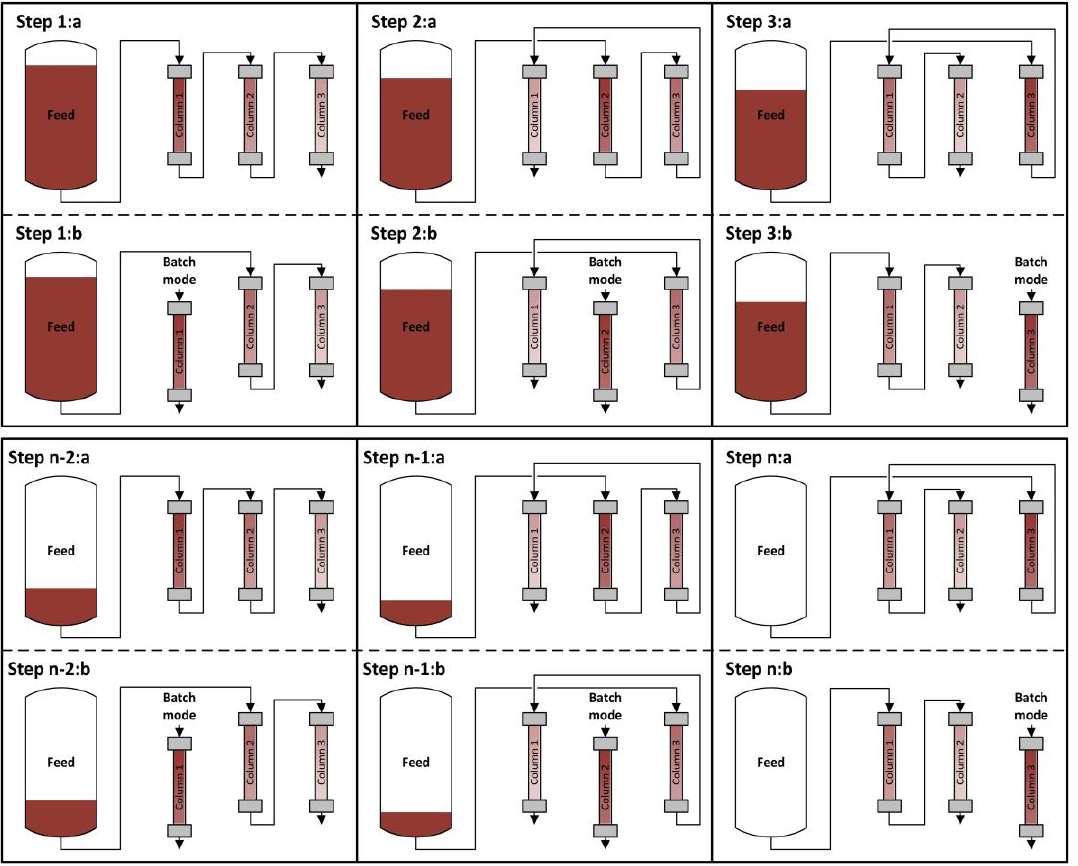
Figure 2. Scheduling of loading and separation phases for a three-column sequential chromatography after batch upstream.